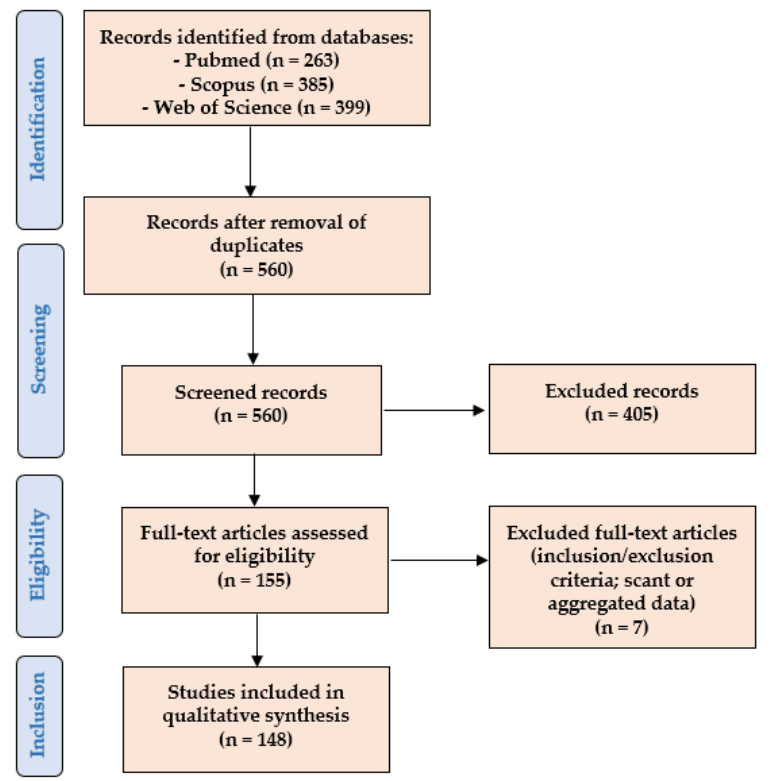
Figure 1. PRISMA flowchart of our systematic literature review.